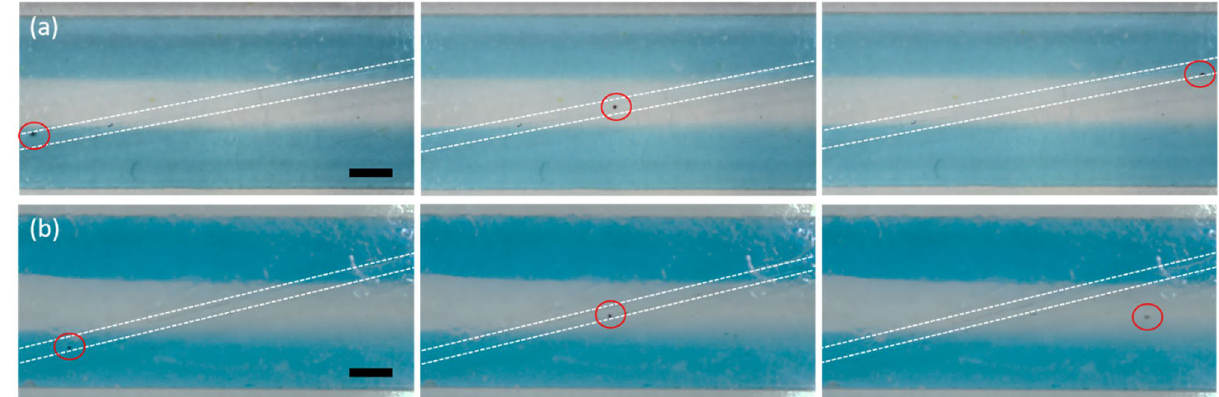
Figure 5. ( a ) Particle following the rail of 10°, depth 45 µm, liquid velocity 12.5 mm/s; ( b ) particle escaping the rail of 15°, depth 73 µm, liquid velocity 12.5 mm/s. Scale bars are 1 mm.